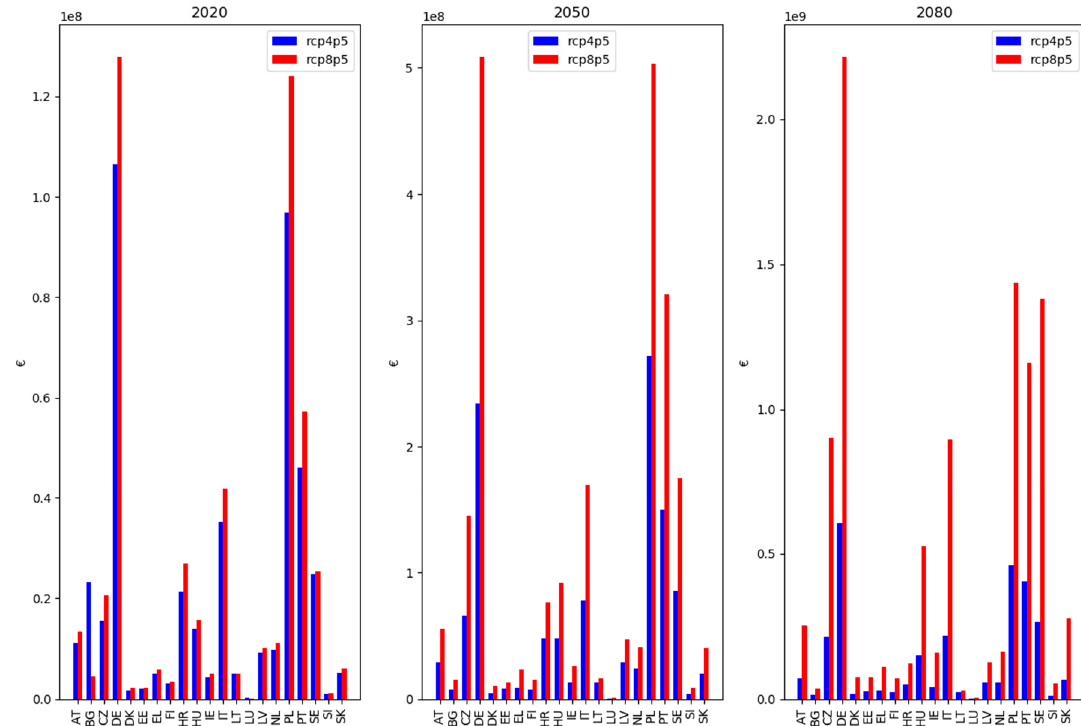
Figure 3. The difference in the total amount of unaffordability in Euros (2015) between hard and soft market conditions, shown for RCP4.5 (blue) and RCP8.5 (red), for individual EU countries in 2020, 2050, and 2080. Countries that provide public reinsurance for flood insurance are excluded here, as these are not exposed to global reinsurance market volatility resulting from large natural catastrophes.